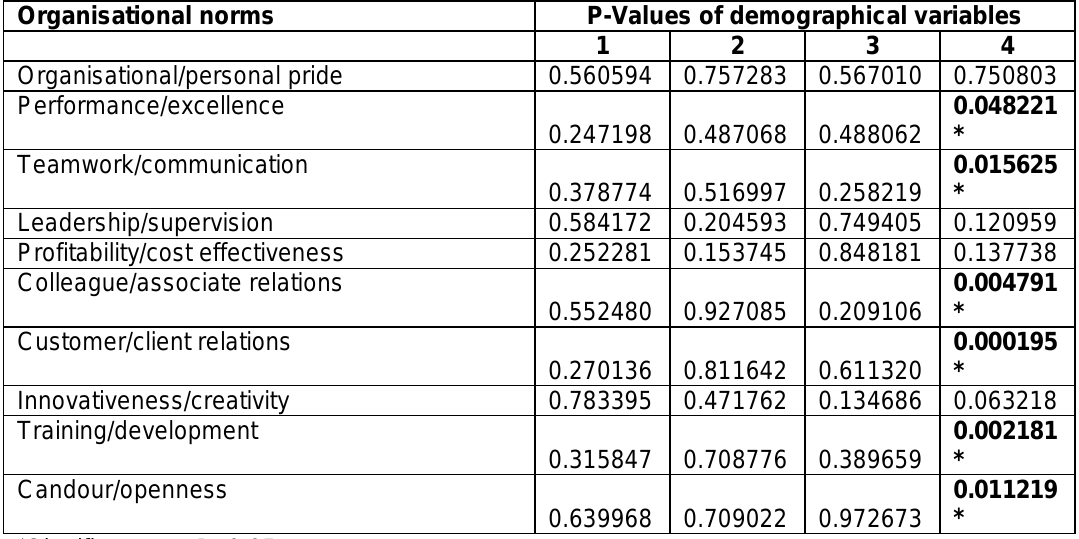
T-test statistics for establishing relationships between norms of and demographical differences of